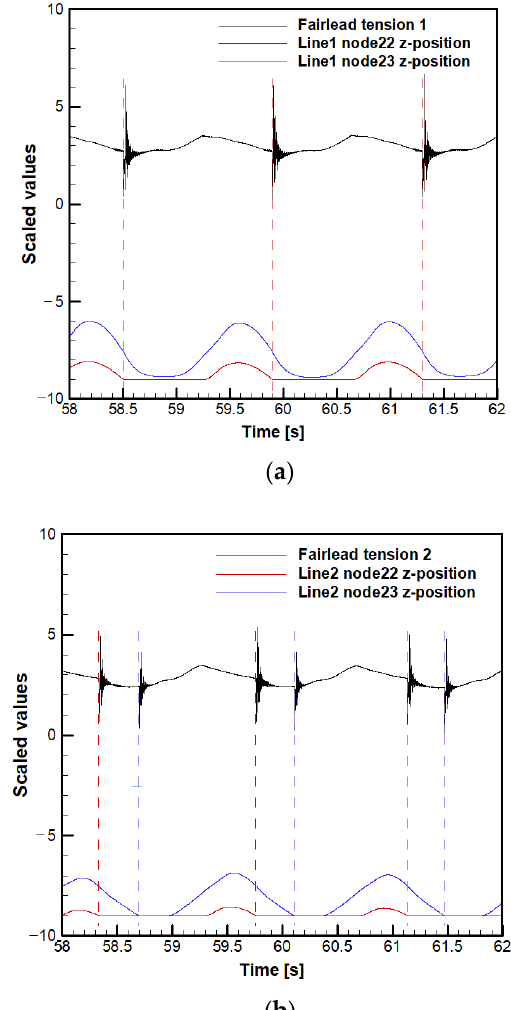
Figure 16. Noise analyses in tensions of moored buoy: ( a ) Mooring line 1; ( b ) Mooring line 2.